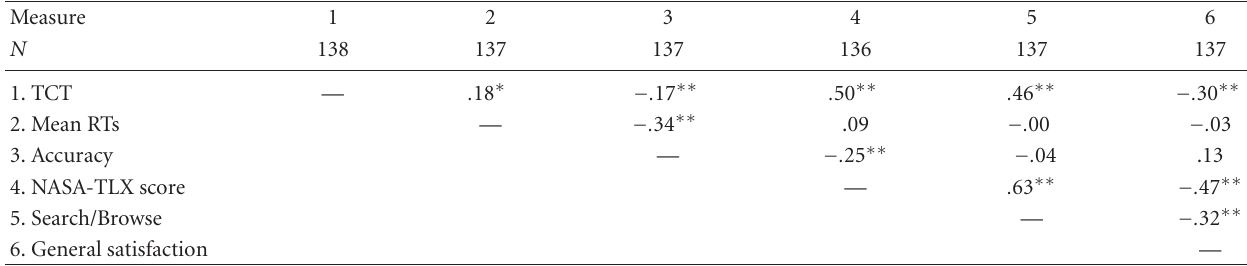
Table 3: Correlations between cognitive load measures and user